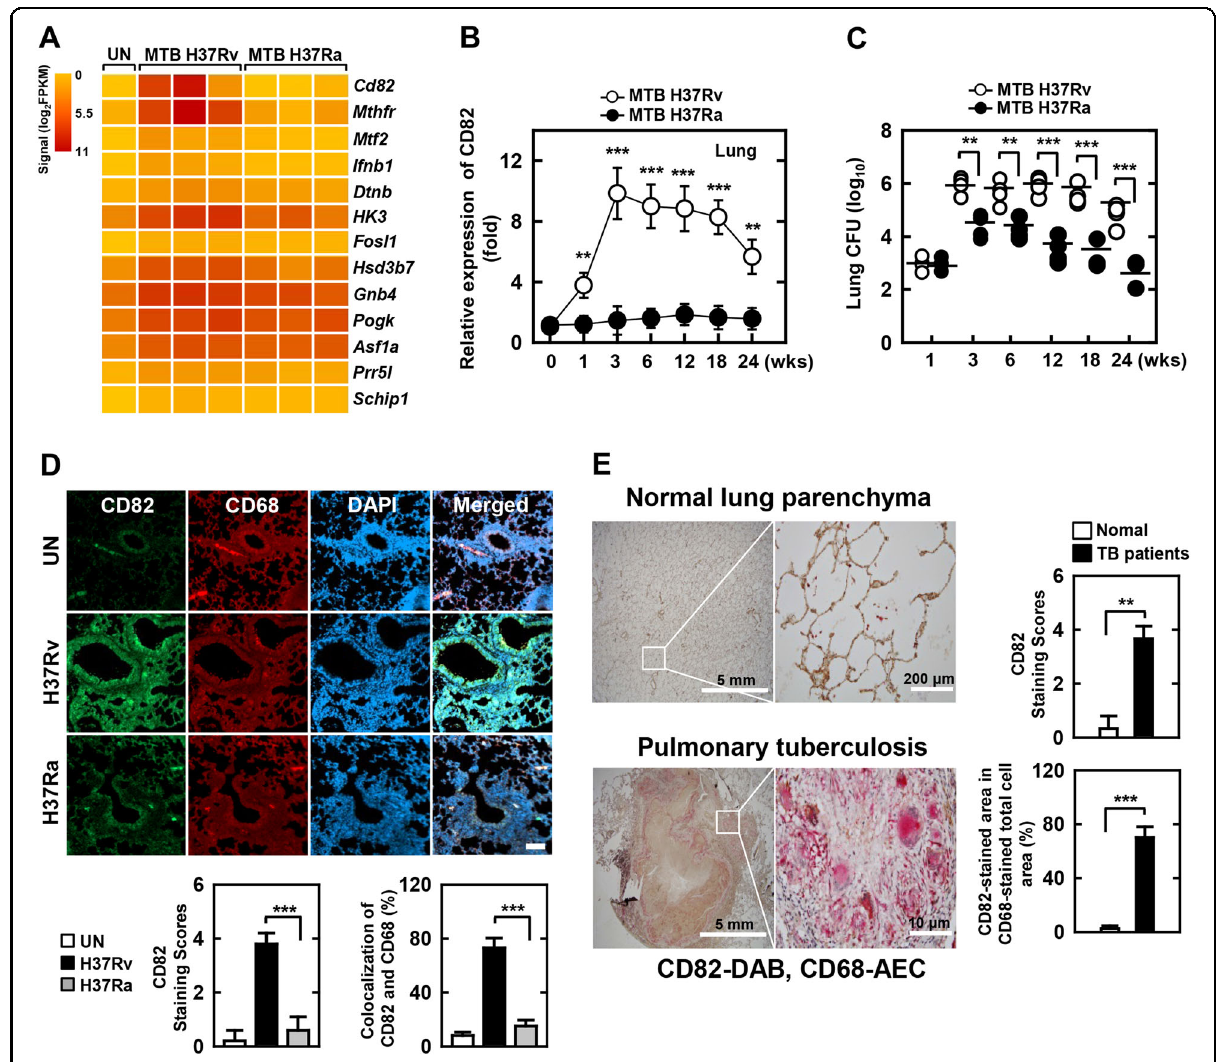
Fig. 1 Identi fi cation of MTB Rv-speci fi c CD82 in mice and TB patients. a Heat map of the top 13 upregulated genes in lungs from MTB Rv- or MTB Ra-infected mice. Each row shows the relative expression level of a single gene, and each column shows the expression level of a single sample. b Real-time qPCR analysis of CD82 expression or c bacterial loads in lungs from MTB Rv- or MTB Ra-intranasal infected mice for the indicated times (as in Fig. S1A). d Representative immuno fl uorescence images for expression of CD82 and CD68 (a macrophage marker) in lungs from MTB Rv- or MTB Ra-infected mice. Scale bar, 100 μ M. The bottom panel shows the quantitative data of staining intensity of CD82 (left) and the colocalization index (%) between CD82 and CD68 (right). e Immunohistochemical analysis to examine CD82-DAB (3,3 ’ -diaminobenzidine) and CD68-AEC (3-amino-9- ethylcarbazole) expression in healthy controls and patients with pulmonary TB. Representative images from fi ve independent healthy controls and patients are shown. Insets, enlargement of outlined areas. Biological replicates ( n = 3) for each condition were performed ( a – d ). Signi fi cant differences (** P < 0.01; *** P < 0.001) compared with MTB Ra (Student ’ s t- test with Bonferroni